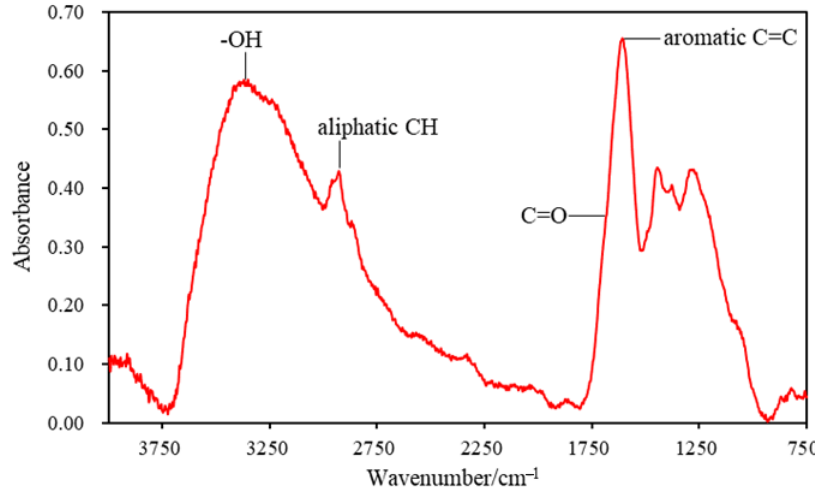
Figure 2. A typical micro-FTIR spectrum of the test points.